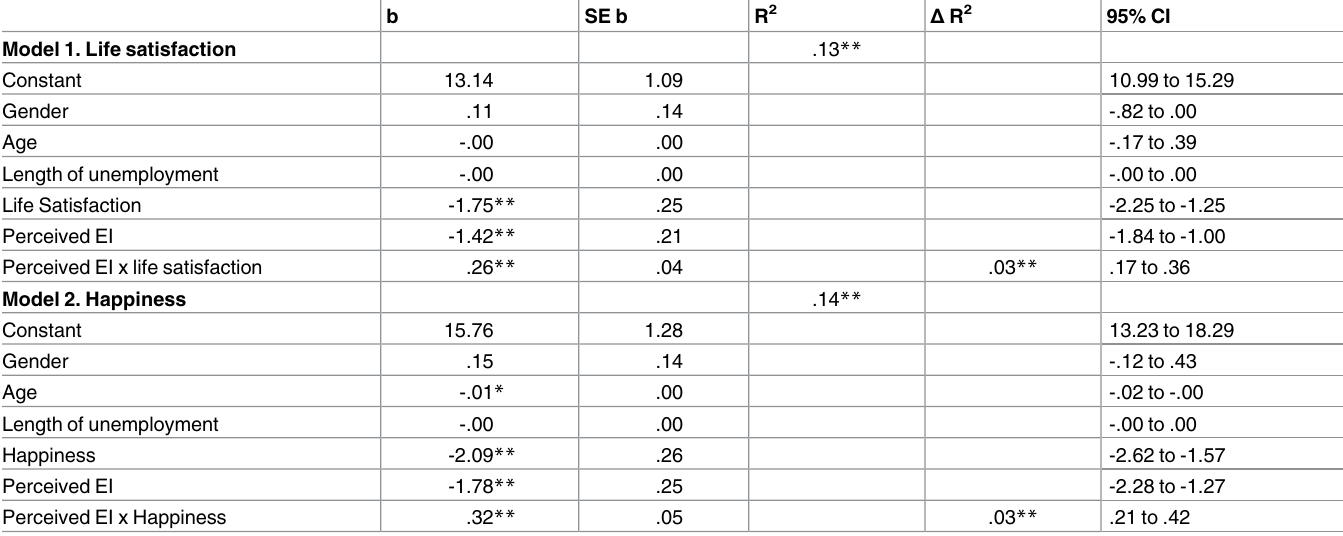
Table 2. Tested moderation models with suicidal ideation as outcome predicted by perceived EI and interactions product. b SE